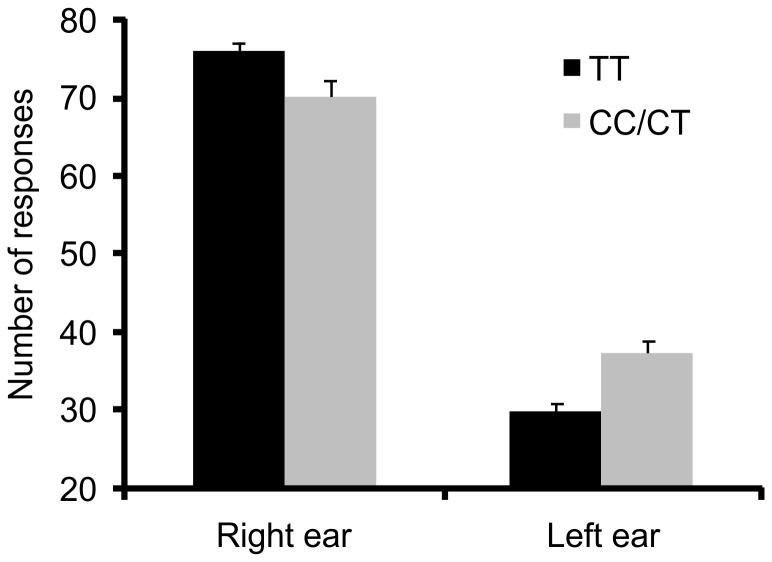
Association of CCKAR rs1800857 genotypes and performance in the dichotic listening task.The absolute number of right-ear and left-ear responses is shown (the maximal number of responses was 120). Error bars show standard error.